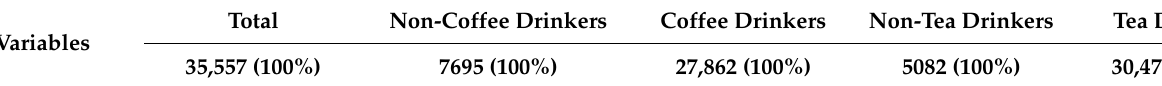
Table 1. Characteristics of coffee drinkers, tea drinkers and those who did not drink coffee or